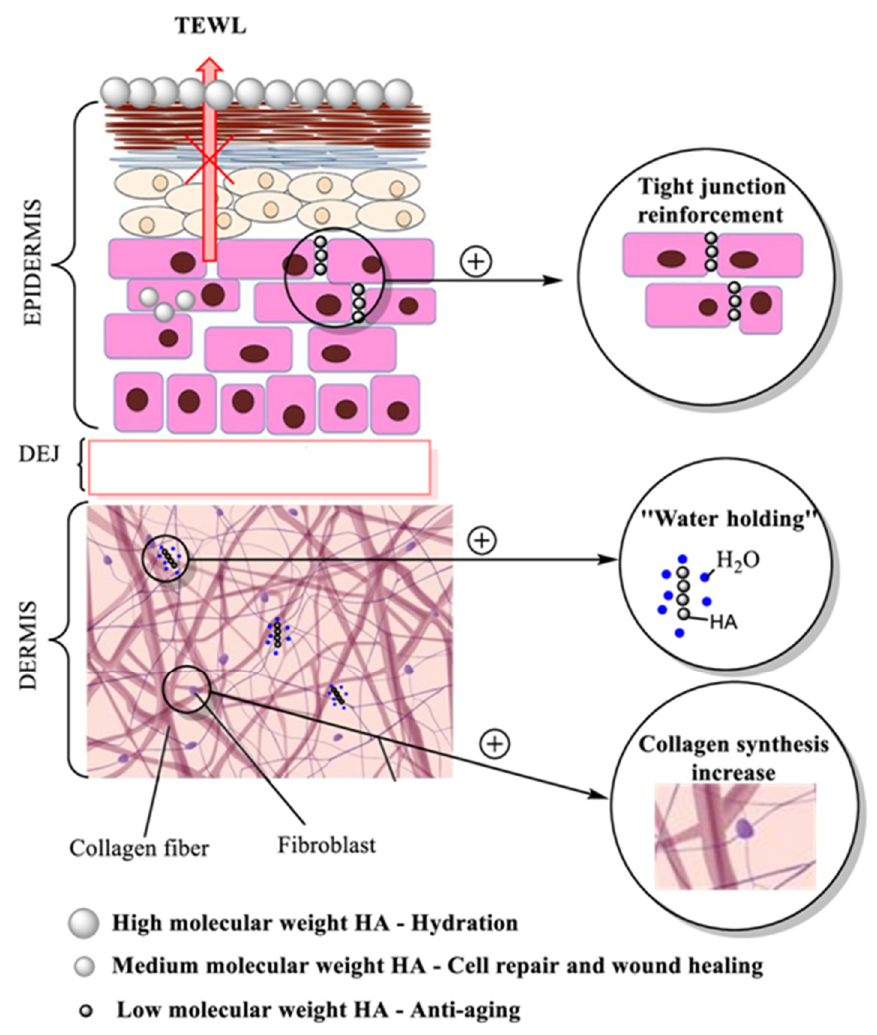
Figure 4. Hyaluronic acid activity, molecular weight dependence and claimed effect of HA. (TEWL—Transepidermal Water Loss; DEJ—Dermoepidermal junction).